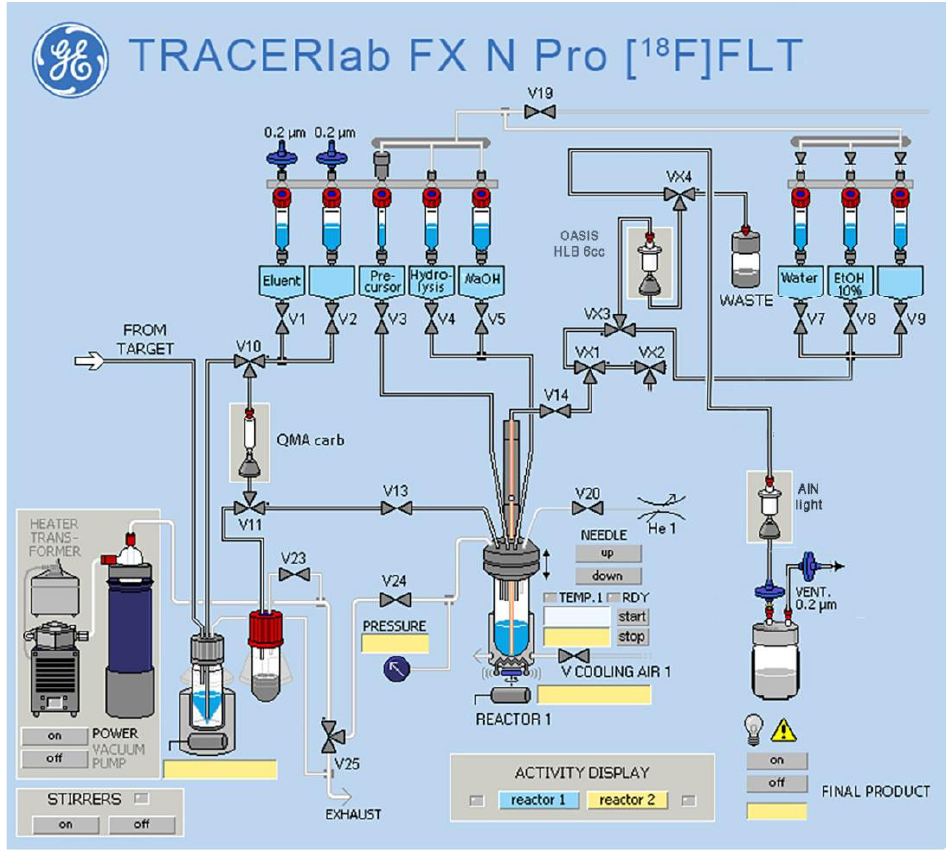
Figure 4. Control panel developed for the synthesis of [ 18 F]FLT on the TRACERlab FX N